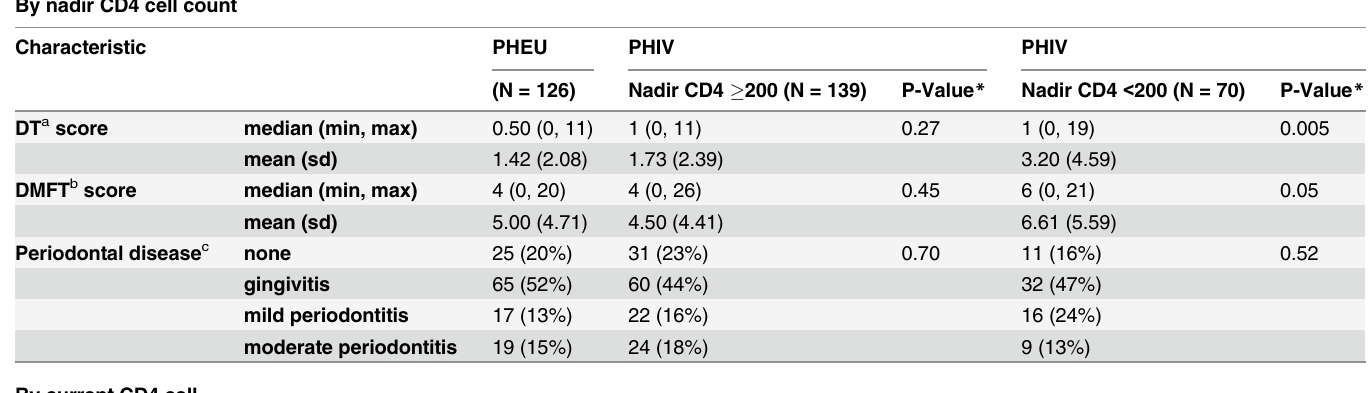
Table 3. Oral diseases by nadir CD4 cell count, current CD4 cell count, or viral load. By nadir CD4 cell